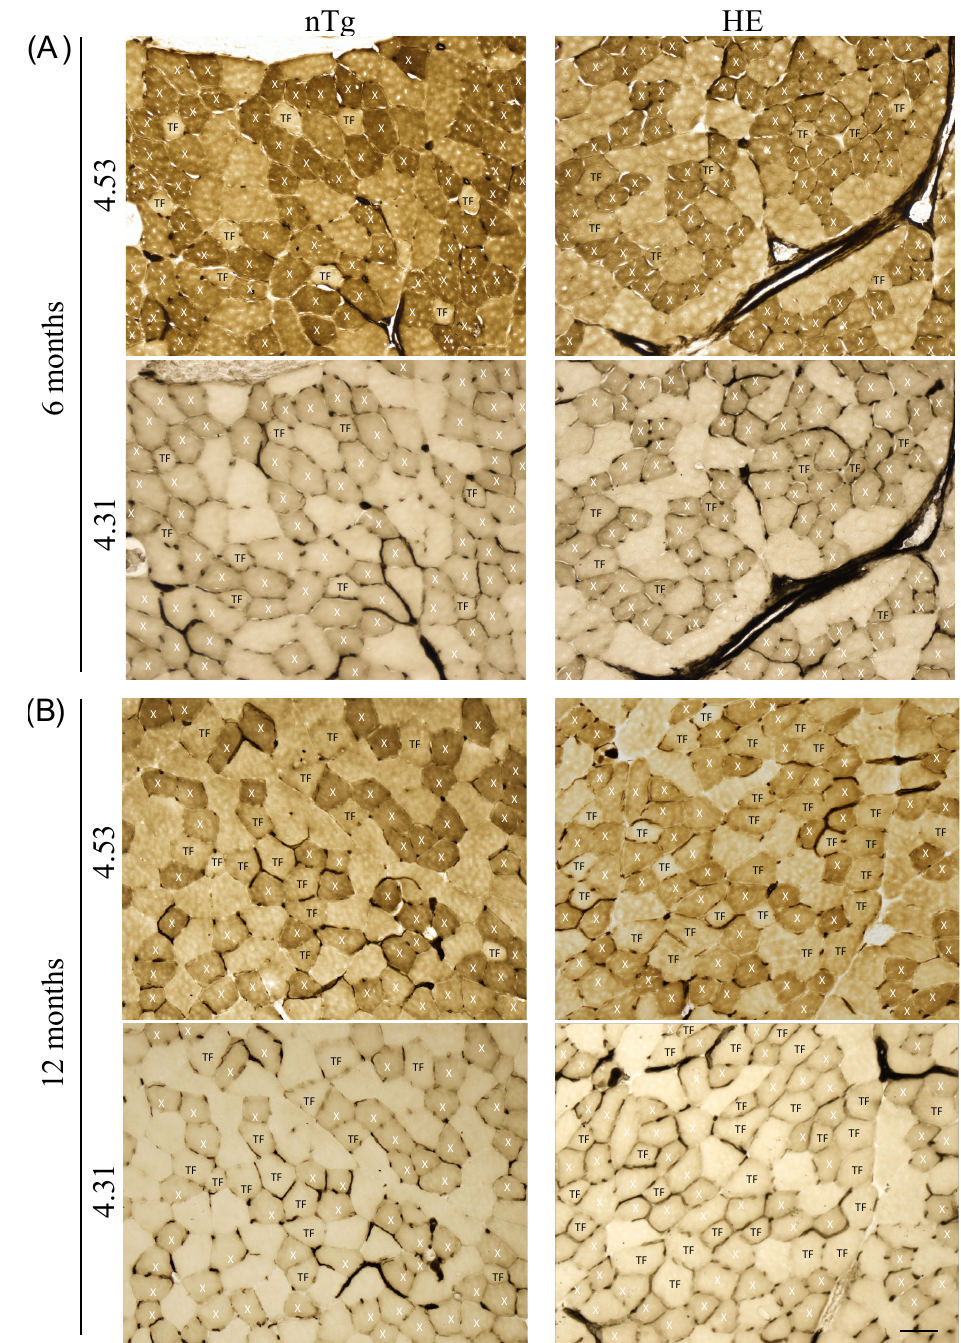
Figure 9. Representative micrographs of serial sections of TA from 6- ( A ) and 12-month-old ( B ) HE and nTg mice after myofibrillar ATPase histochemistry. Serial sections were either preincubated at pH 4.53 or at pH 4.31. At pH 4.53, type 2B fibers are brown, type 2A fibers are the lightest, and type 2X fibers appear dark brown. At pH 4.31, type 2X fibers are light brown and type 2A and 2B fibers are the lightest/colorless. Based on the staining at the two pH, X indicate the 2X fiber type, and TF correspond to transition fibers light brown at pH 4.53 and light/colorless at pH 4.31. Scale bar: 50 µm.